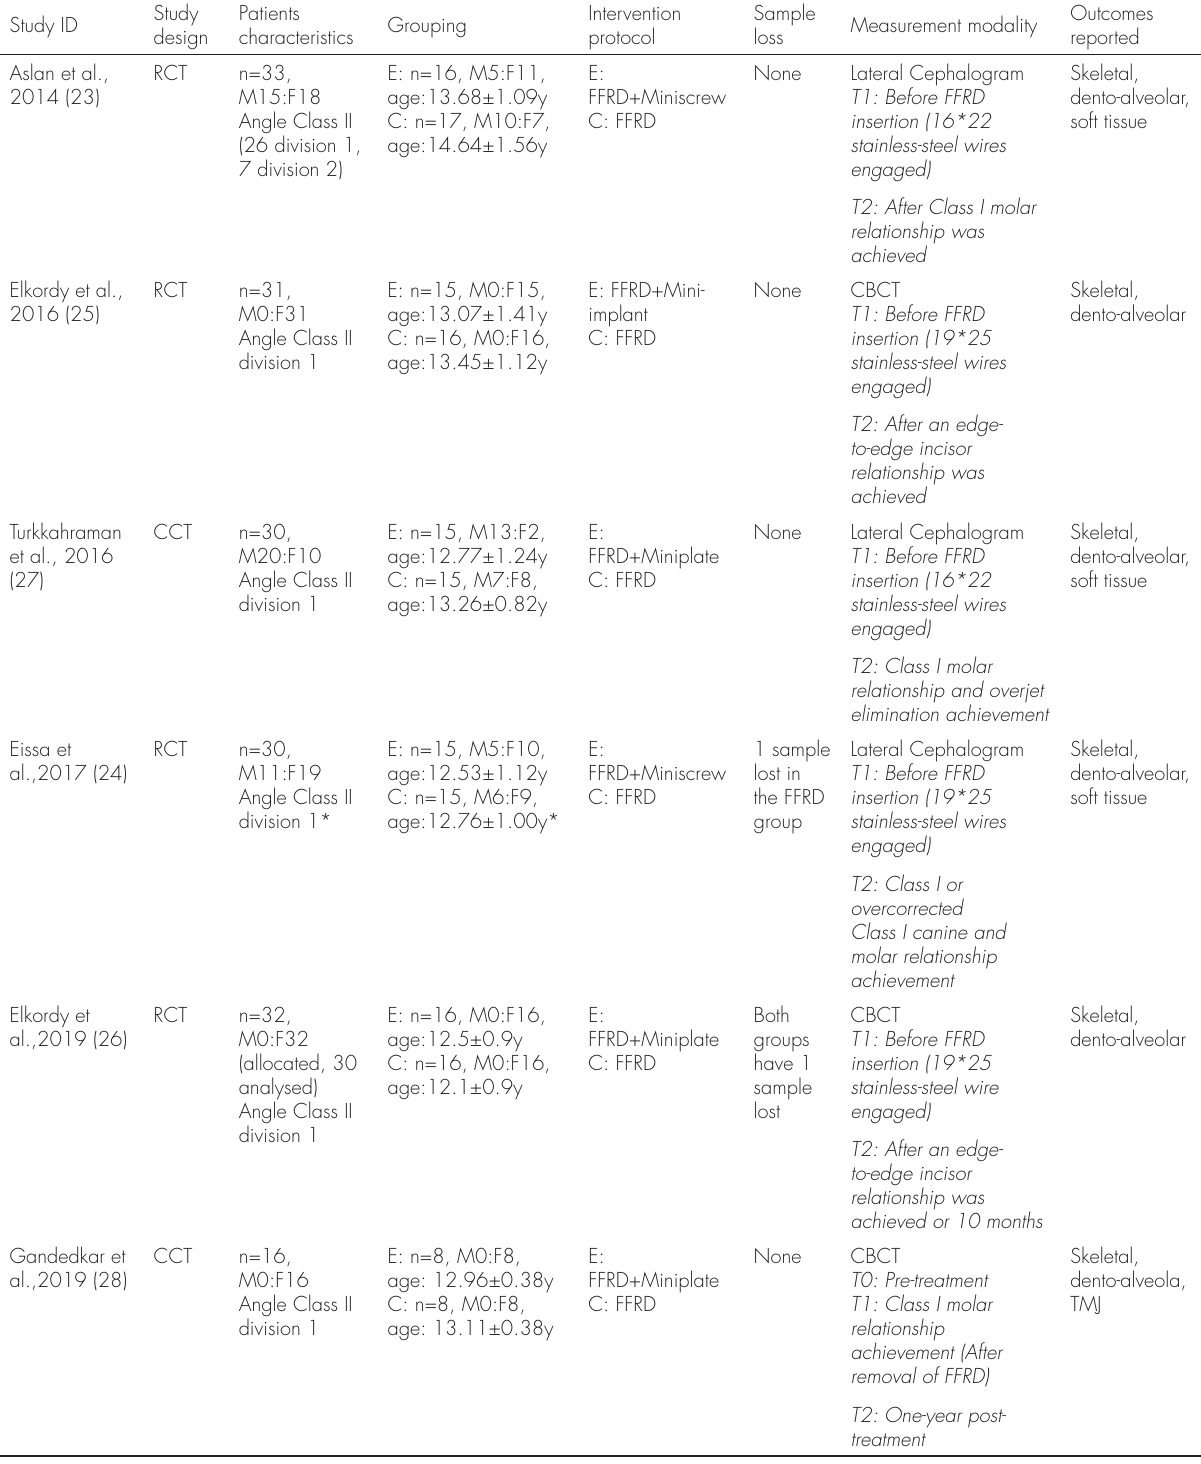
Table II. General information about included